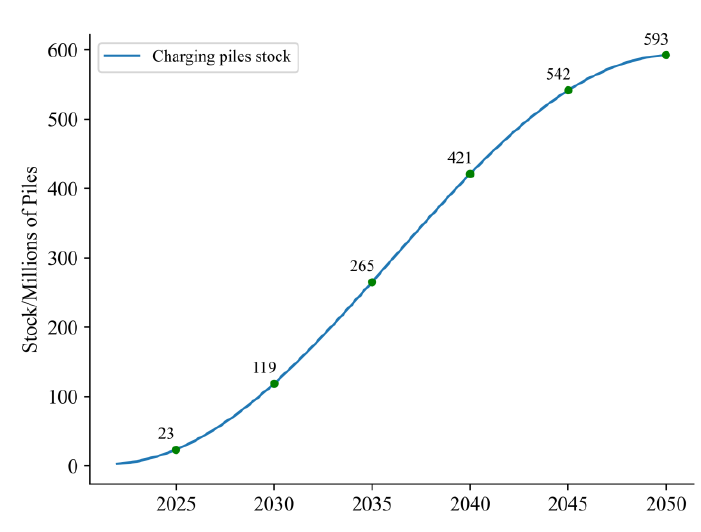
Figure 2. The Number of Charging Piles from 2020 to 2050.